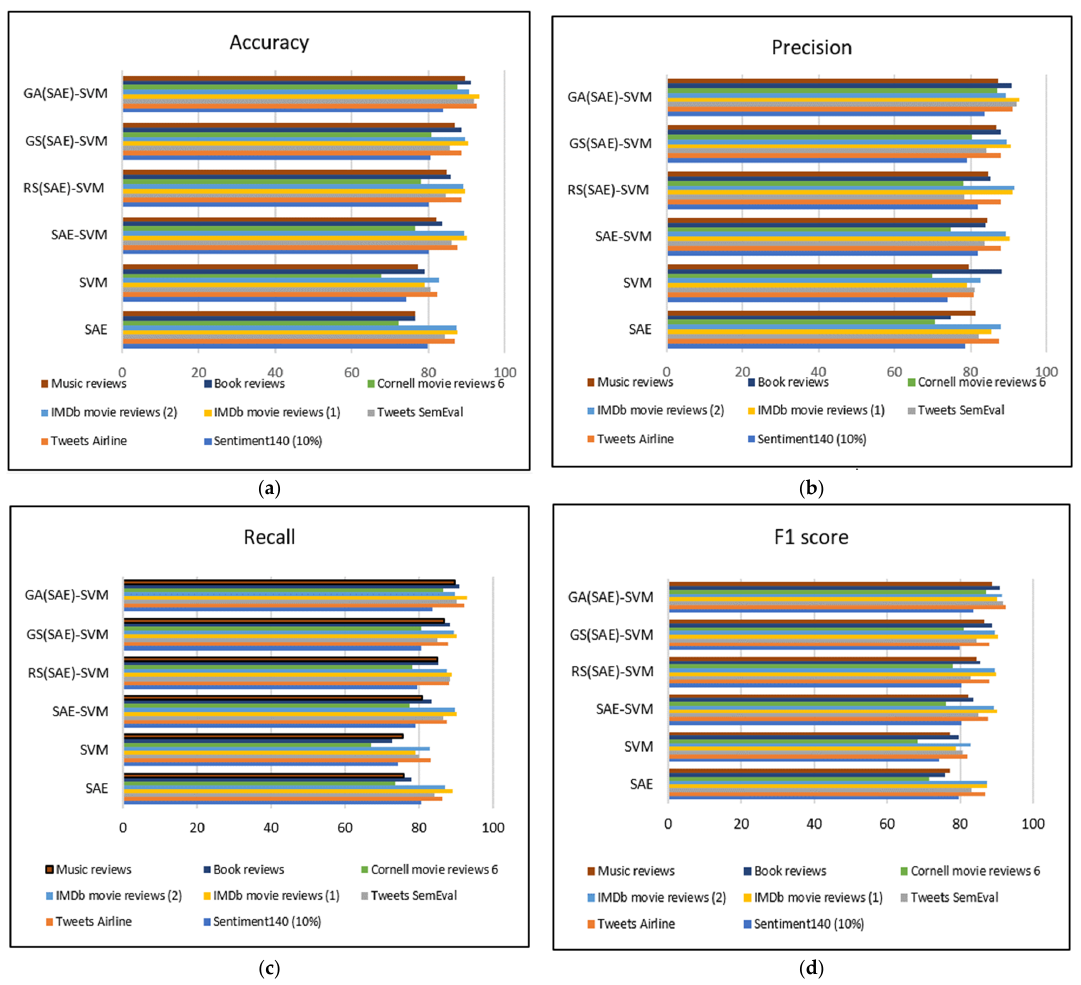
Figure 4. Performance evaluation of all models.